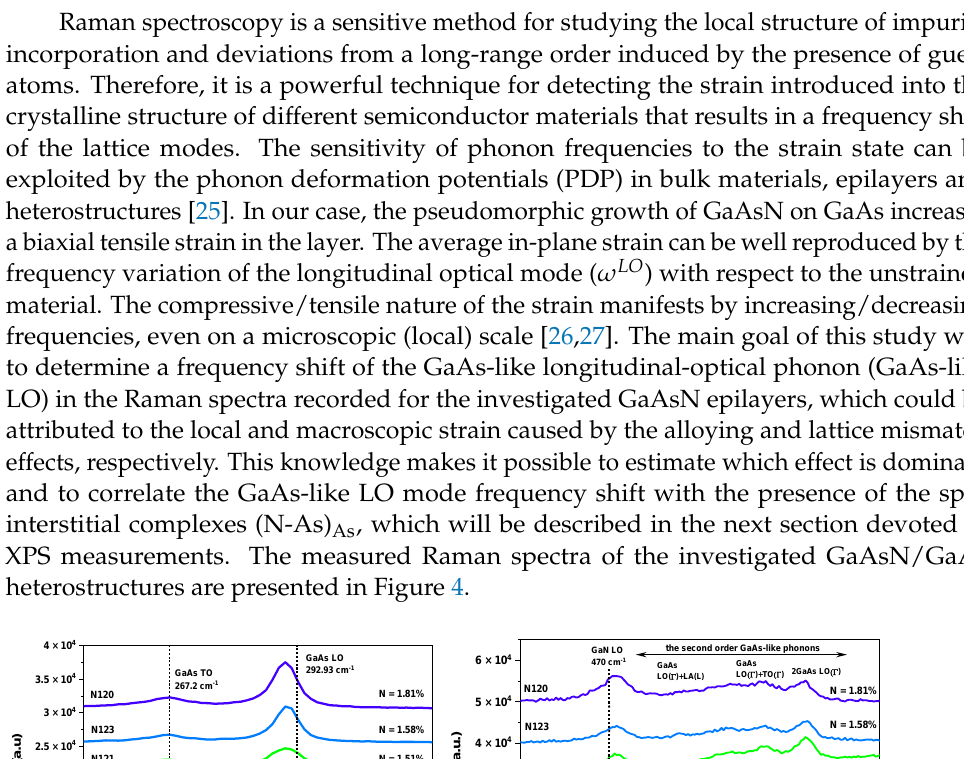
Figure 3. High resolution X-ray diffraction results: ( a ) the diffraction curves of all investigated heterostructures measured for (004) reflection; ( b ) the reciprocal space map for the (115) asymmetrical reflection of the sample N120 ( N = 1.81%, d = 130 nm).